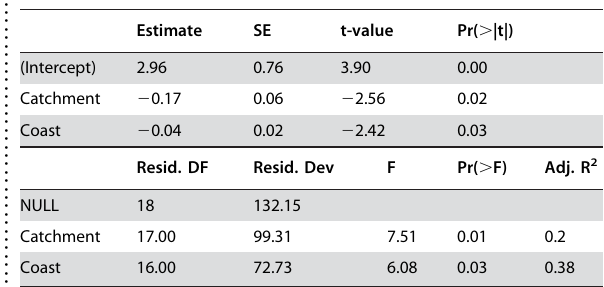
Table 5. Summary statistics of the generalized linear mixed